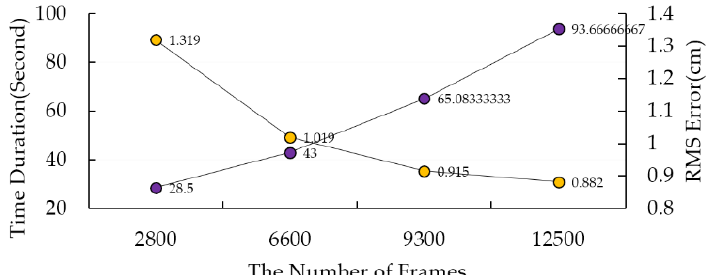
Figure 5. Results of algorithm fitting with different numbers of data frames. Yellow circle means the RMS error and purple one means the time duration of each layer.